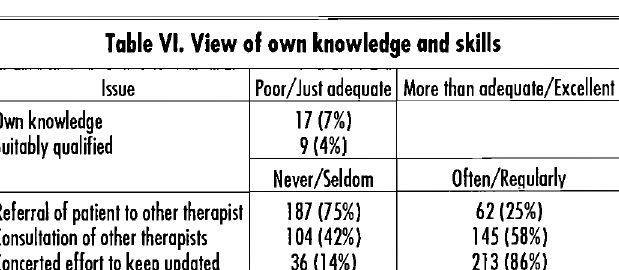
Table VI. View of own knowledge and